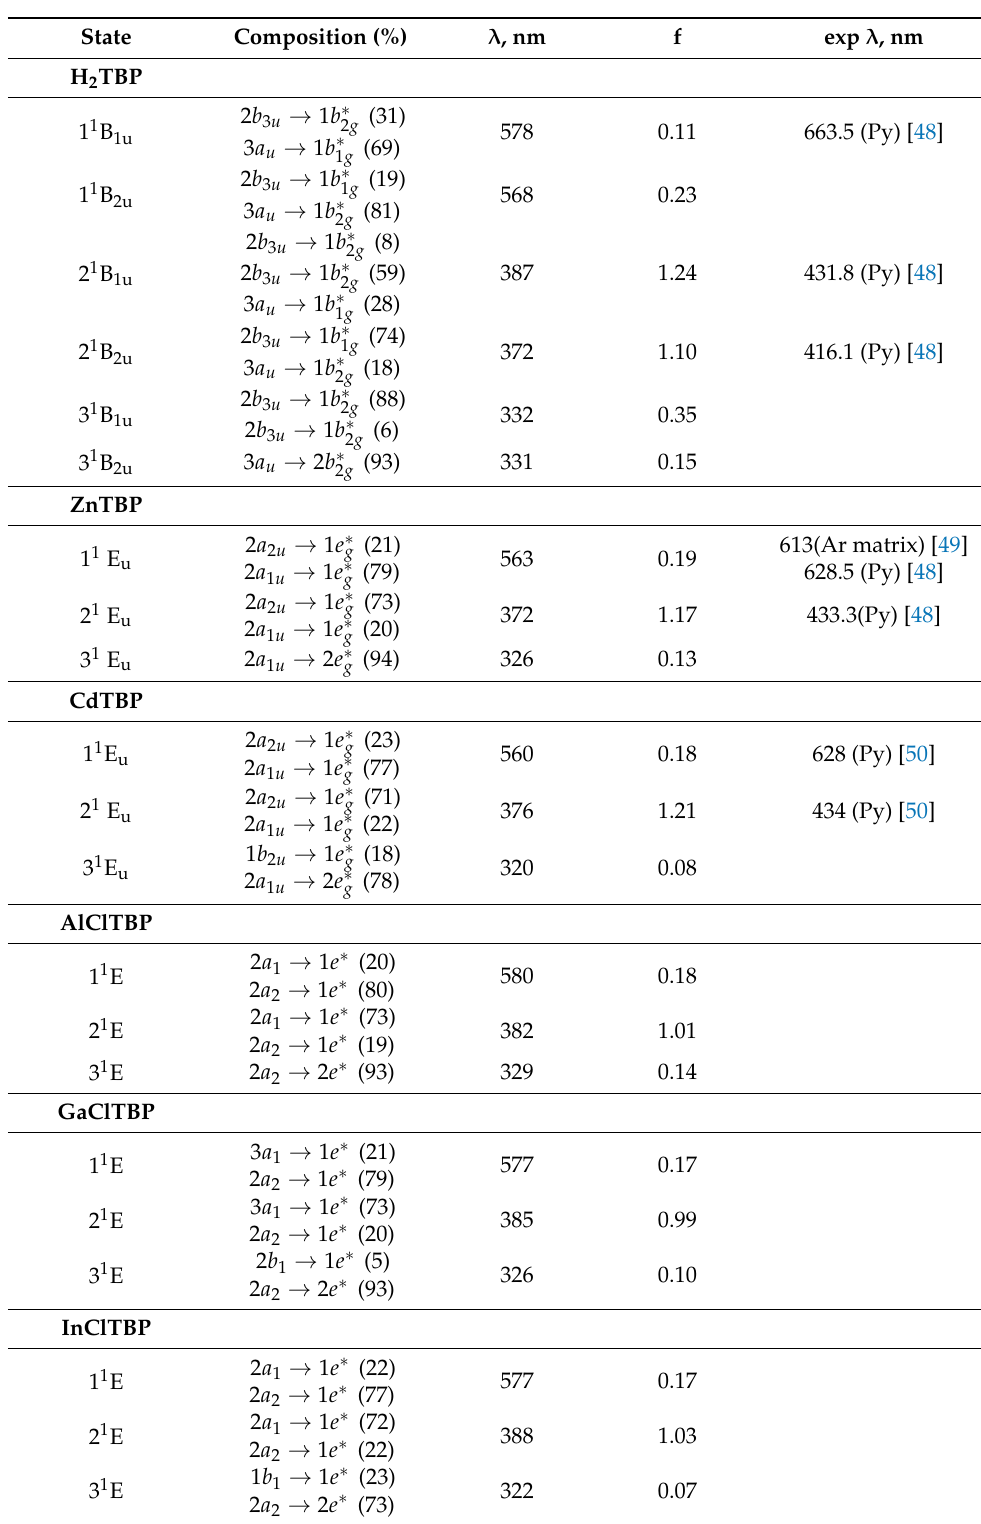
Table 3. Calculated composition of the lowest excited states and corresponding oscillator strengths for H 2 TBP and MTBP